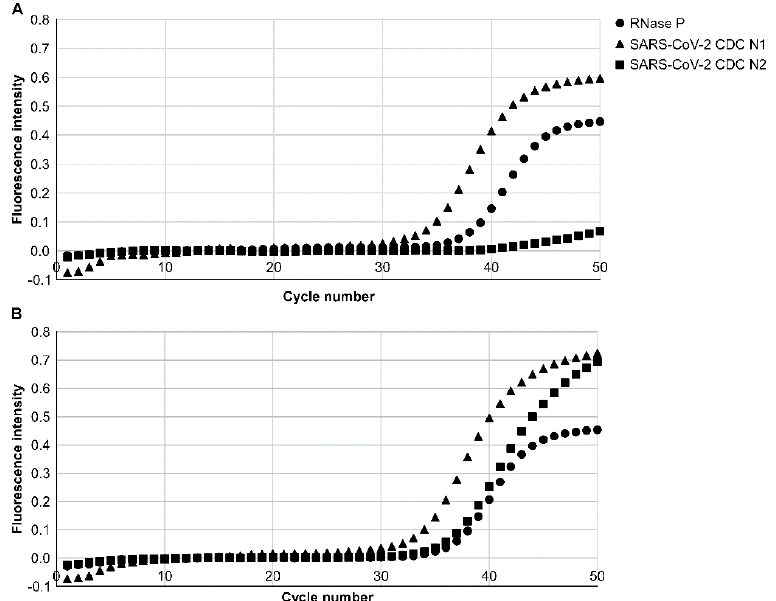
Figure 2. qPCR results by PCR1100 of patient 4. ( A ) Results of the qPCR using the old version (Ver. 1). RNase P was detected with a Ct value of 36.0, indicating that there was no problem with the PCR. CDC N1 increased at a Ct value of 33.0, and severe acute respiratory syndrome coronavirus 2 (SARS-CoV-2) viral RNA was detected. At this time, CDC N2 was not detected. ( B ) Results of the qPCR